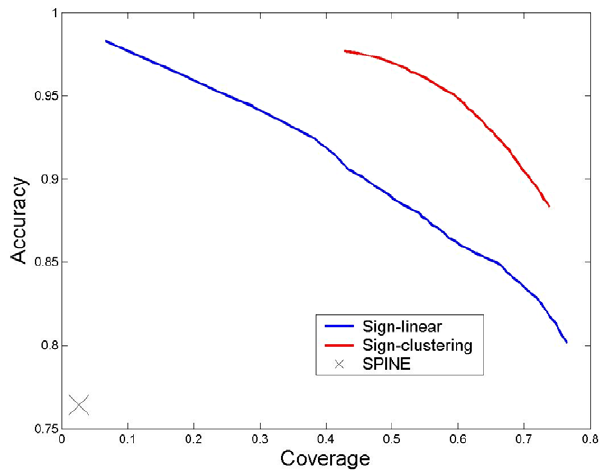
Figure 2. Accuracy versus coverage in the prediction of knockout effects on the genome-wide knockout data set. Results for the sign-linear and sign-clustering algorithms are displayed for different decision cutoffs. The results were obtained using cross validation, each time leaving out 200 knockout pairs. Results for SPINE are presented for its node variant as provided by [6], without using cross validation.